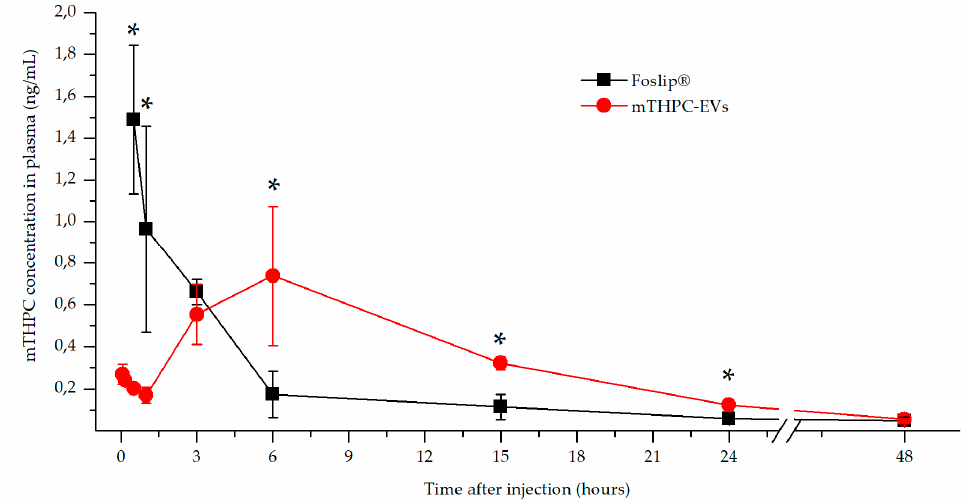
Figure 2. mTHPC concentration in plasma in function of time after injection. Intravenous injections of mTHPC-EVs or Foslip ® in human colon (HT-29) tumor-bearing mice were realized with 0.30 mg/kg of mTHPC. * p < 0.05.